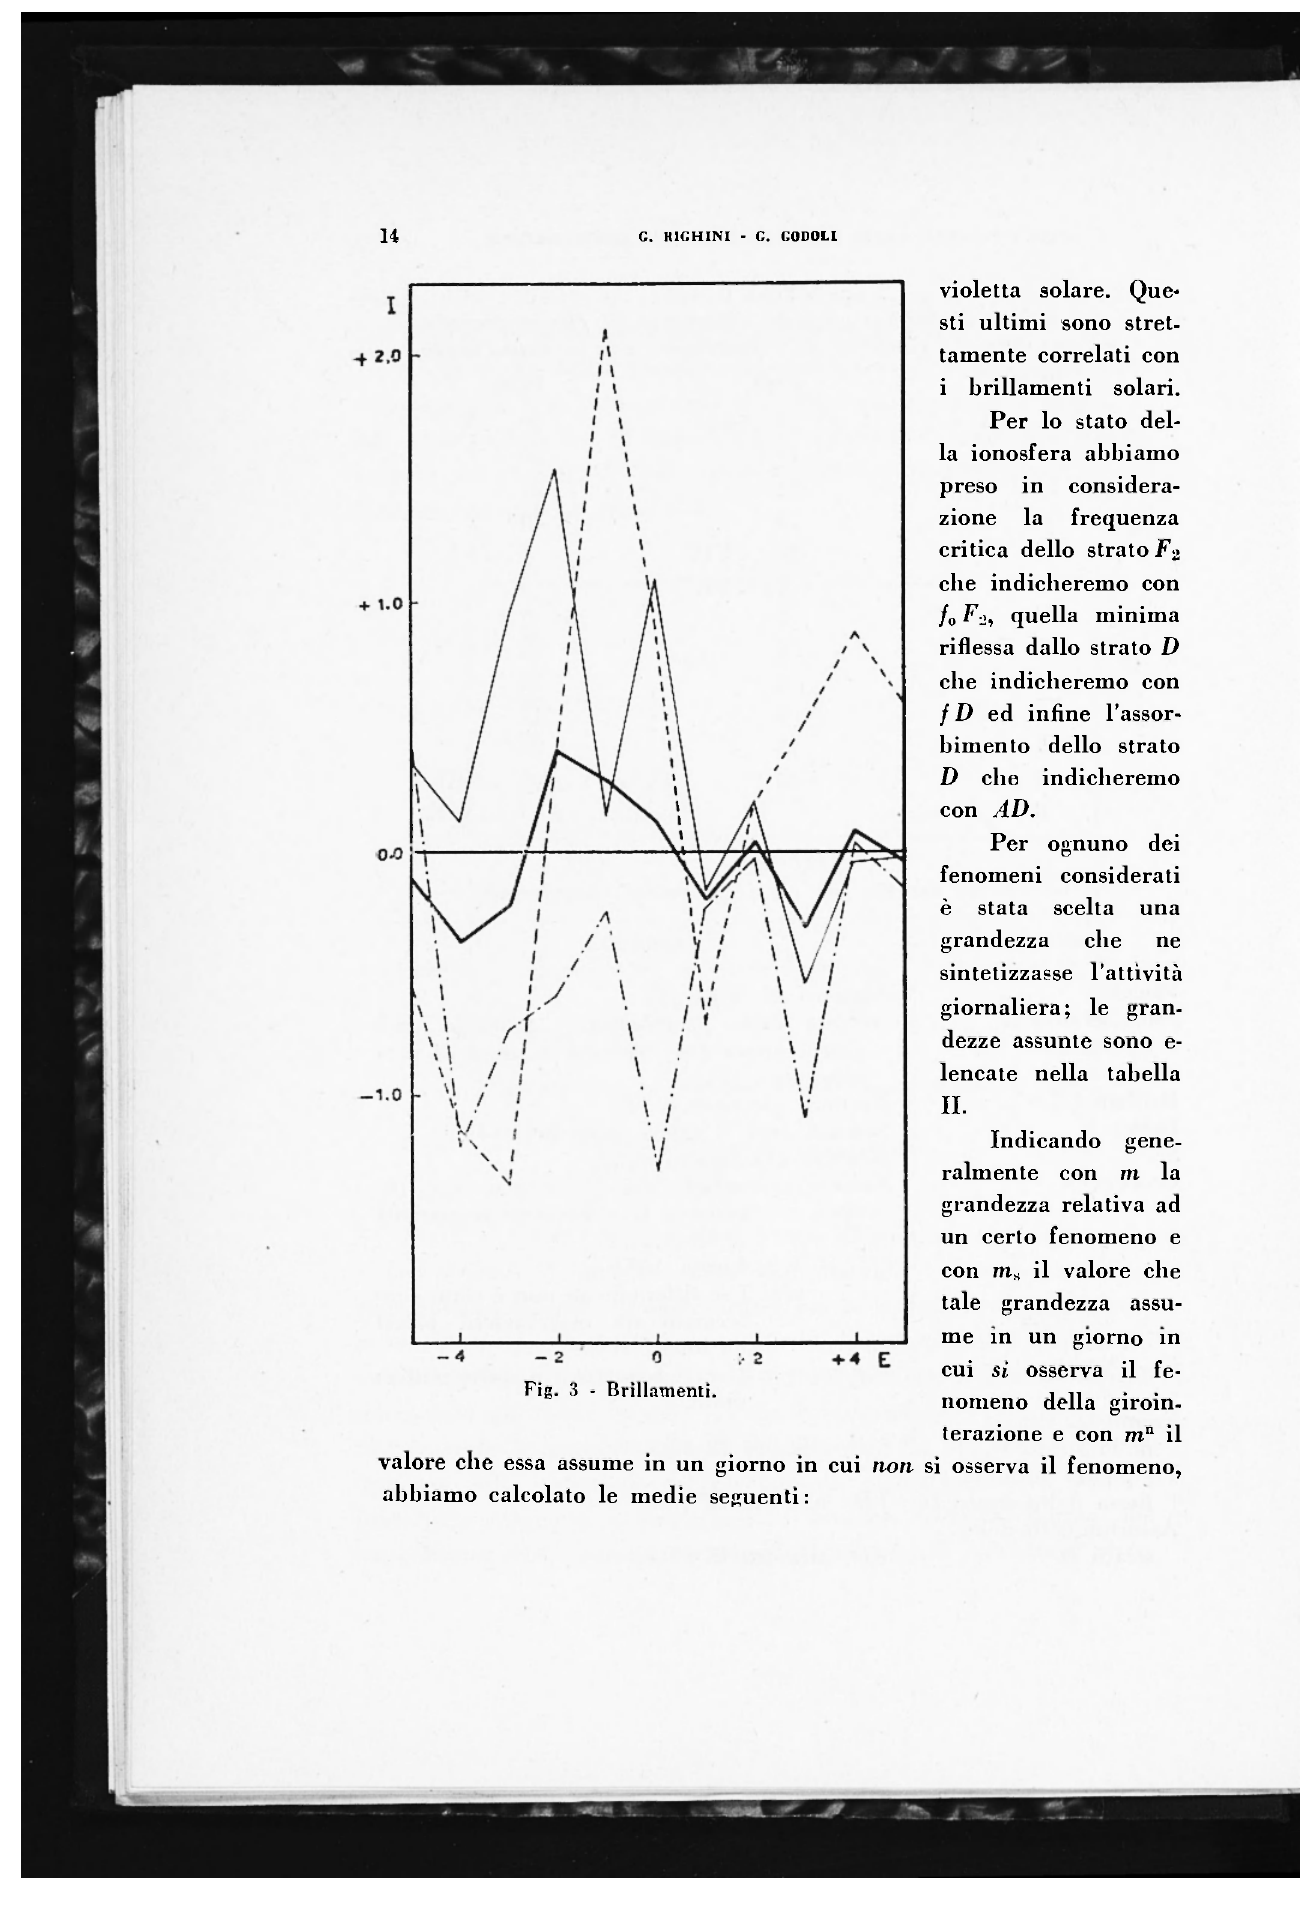
Fig. 3 - Brillamenti.